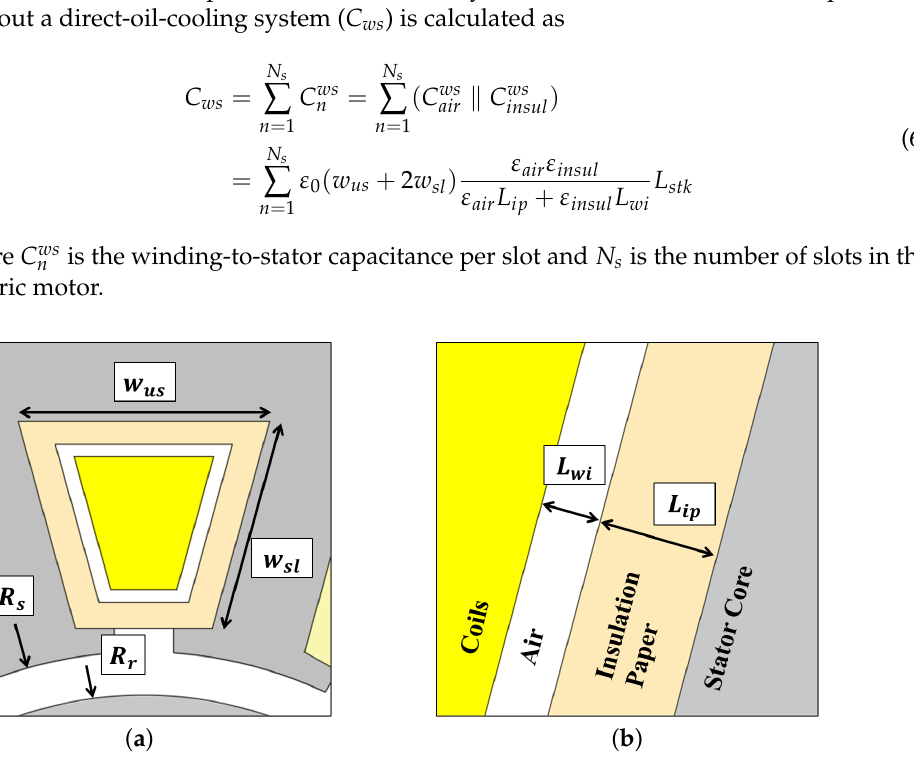
Figure 5. Design variables for winding-to-stator: ( a ) slot structure, and ( b ) side view of the slot. In the direct-oil-cooling system, the slots of the electric motor are classified into oil- filled and oil-unfilled slots because a portion of the stator is submerged in cooling